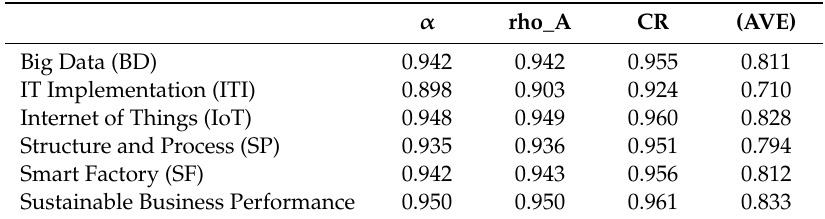
Table 4. Reliability and Convergent Validity.